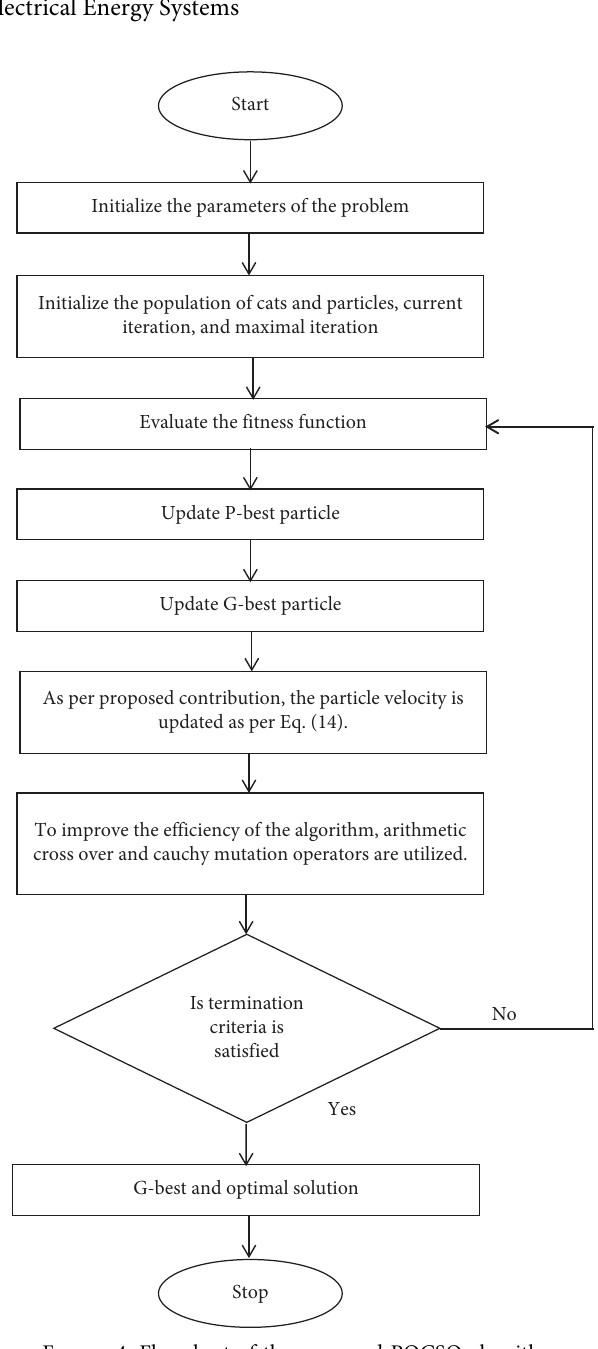
Figure 4: Flowchart of the proposed POCSO